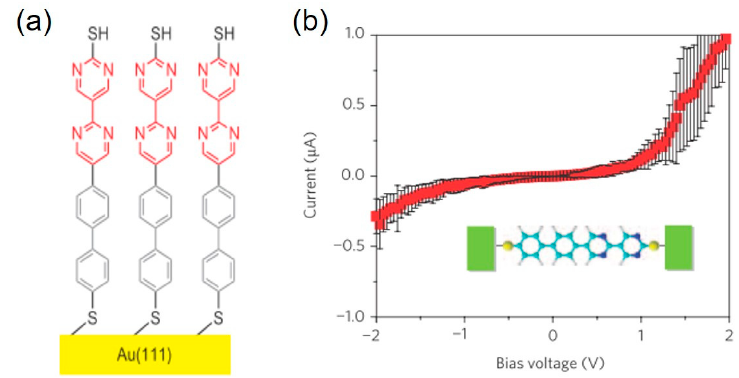
Figure 1. ( a ) The molecular diode with the diblock molecule. An electron deficient bipyrimidinyl unit is bound to an electron rich biphenyl unit via a covalent bond. ( b ) Average I – V curves of the single-molecule junctions of the diblock molecule. Reproduced with permission from [15], copyright Nature Chemistry Group 2009.